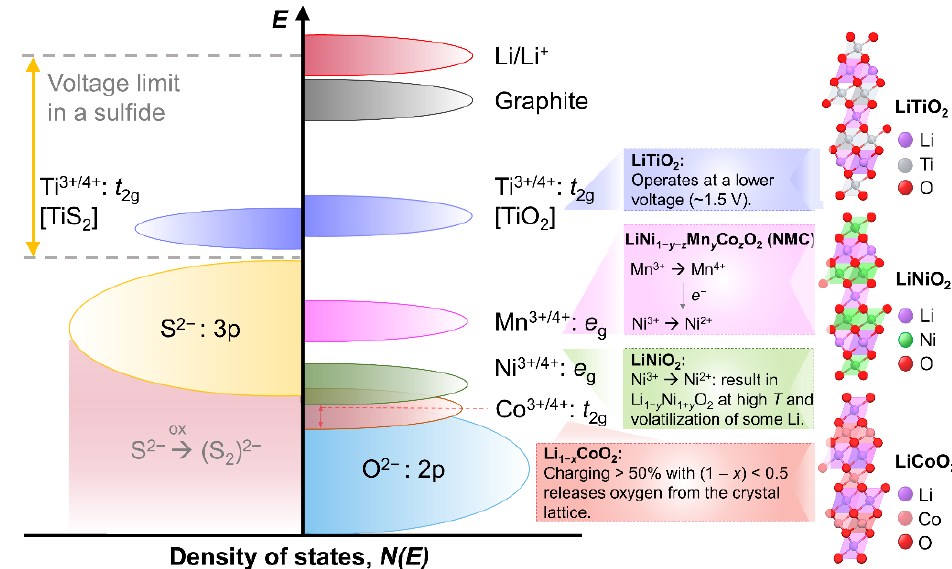
Figure 2. Positions of the redox energies relative to the top of the S 2– and O 2– p bands for the sulfide and oxide cathodes, respectively. Sulfide cathodes have limited cell voltage due to the higher energy of the S 2 − :3p relative to O 2 − :2p (Adapted from Ref. [5]). Sample layered oxide compounds and their respective crystal structures [41] are shown.